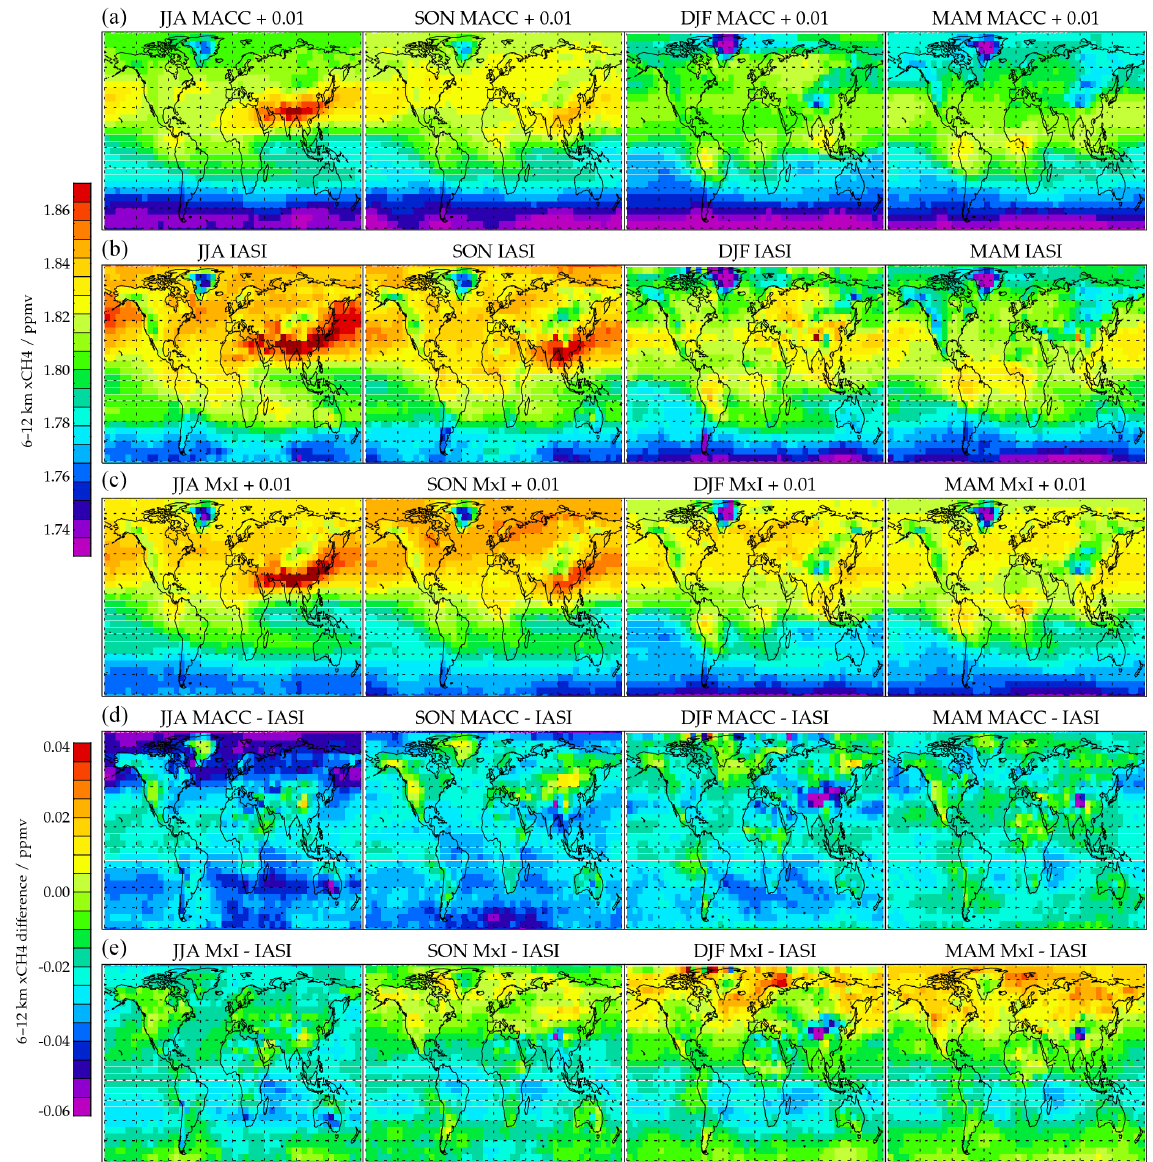
Figure 8. Comparisons of IASI and MACC-II GHG 6–12km ( z ∗ ) layer-averaged mixing ratio. Daytime only results shown. Panels (a–c) show, respectively, results from MACC-II GHG, IASI and MACC-II GHG with the IASI averaging kernels applied (MxI). MACC and MxI results have 0.01ppmv added, as indicated in the plot title. Panels (d, e) show differences between MACC and IASI directly and after applying the IASI averaging kernels (without any offset applied to MACC or